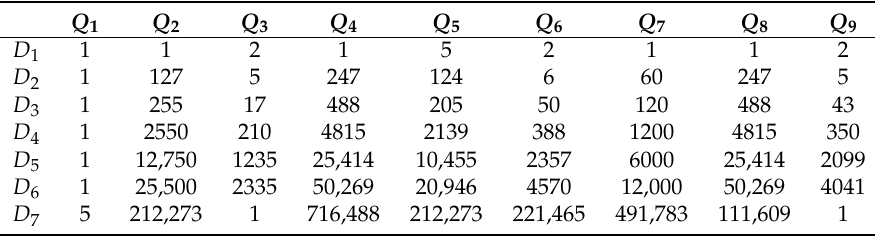
Table 4. Numbers of elements satisfying the queries in the datasets.